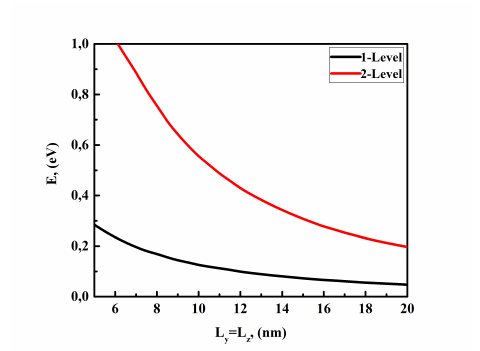
Fig. 2. Dependence of the electron energy in a